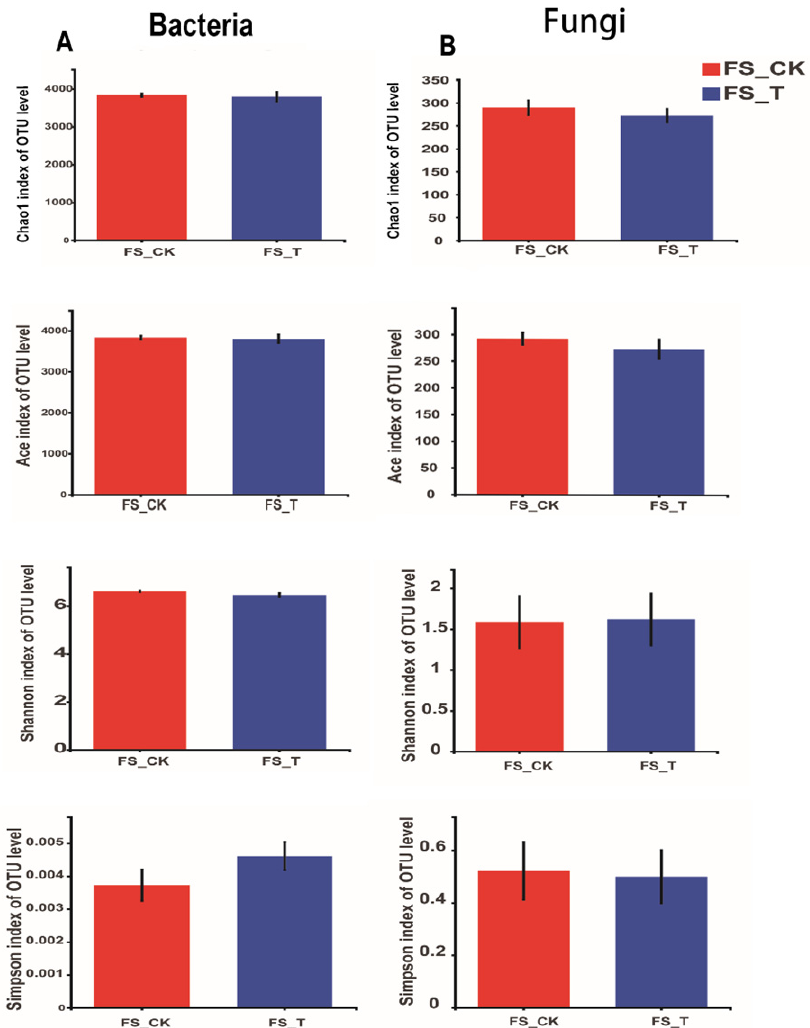
Figure 1. Chao1, ACE, Shannon and Simpson indices showing taxonomic changes in ( A ) bacteria and ( B ) fungi in triple-fumigated soil that had been used to produce tomatoes. The t -test reported the statistical differences (asterisked) between the means of three replicates within each graph. ‘Tri- ple fumigation’ refers to the simultaneous application of chloropicrin, dimethyl disulfide and metham sodium.